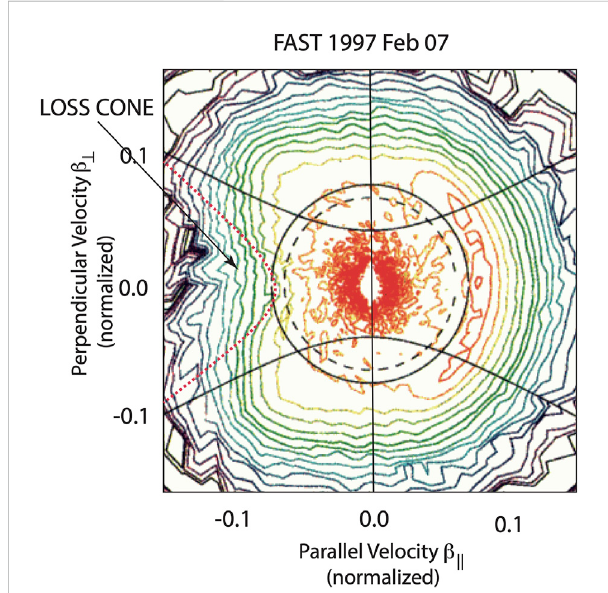
FIGURE 2 Measured loss-cone distributioninthepresumableAKR upward- current auroral source region [after 10, which should be consulted for a detailed description of the observations]. The intensity of downward electron fl uxes is color-coded (from black to red, covering fi ve ordersof fl uxmagnitude),withredhavingthehighestintensities,here, indicating the denser warm auroral-magnetospheric electron background. The comparably wide upward (negative normalized parallel velocities β (cid:3) = v (cid:3) / c < 0) electron loss-cone is well exhibited. Circles show the theoretical (solid) and observed (dashed) low-speed bounds. At positive parallel speeds, the red banana indicates the high- energy downward auroral electron beam. The two black hyperbolas are theoretical angular limits of inner and outer phase-space regions. The dotted red hyperbola at negative (upward) β (cid:3) is the resonant hyperbola about along the loss-cone boundary with k (cid:3) c > ω . Positive perpendicular gradients along and inside this hyperbola contribute to resonant ECMI growth. The loss-cone is wide enough to host a continuity of such hyperboles inside its bounds, thus providing the ECMI with abandwidth Δ ω atconstant frequency ω . Uncertainty ofthe observations is too large for calculating quantitative numbers (Modi fi ed and adapted from Ref. [14]. Courtesy